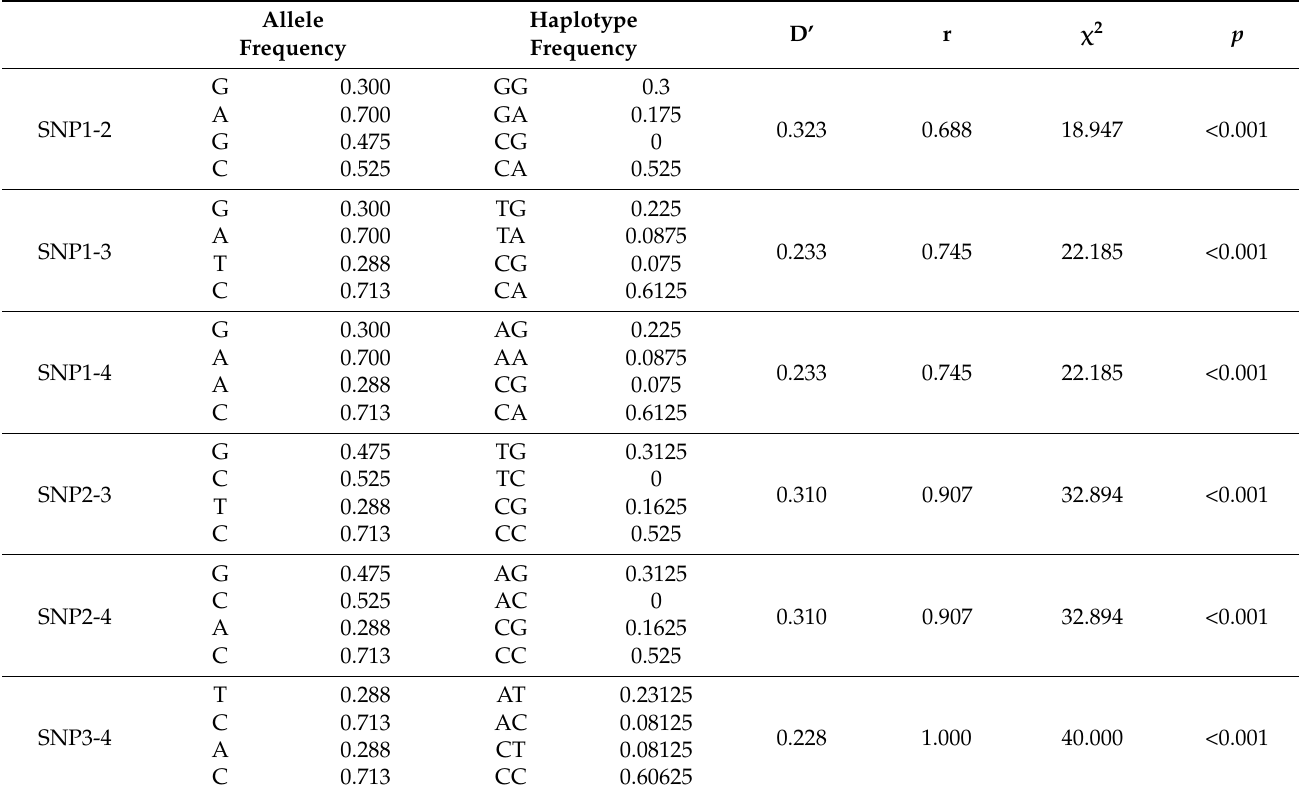
Table 2. Allele and haplotype frequency distribution and linkage disequilibrium in the case of tested